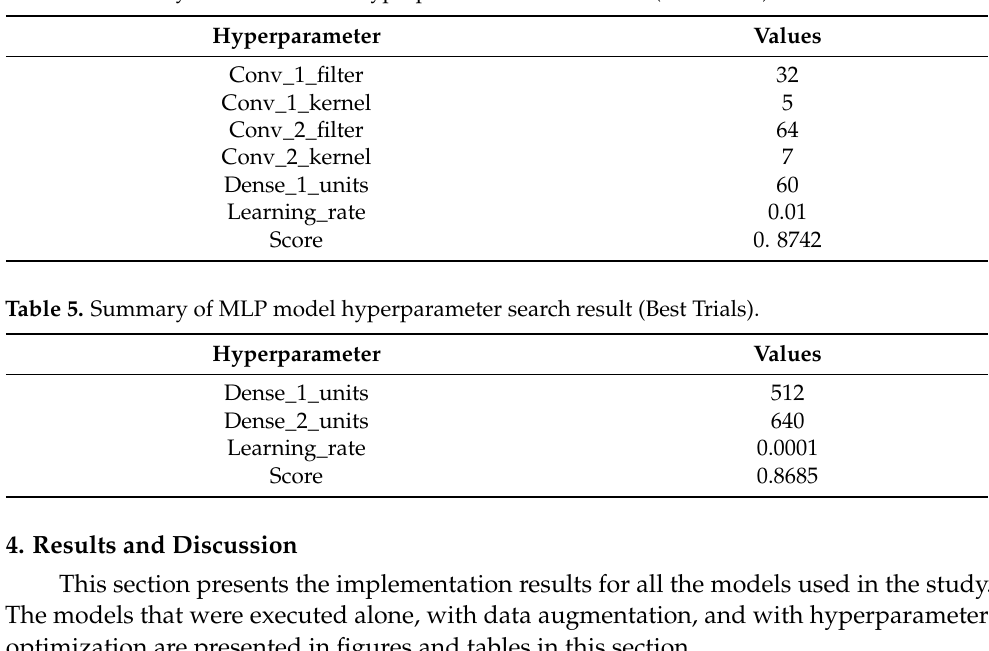
Table 4. Summary of CNN Models hyperparameter search result (Best Trials).